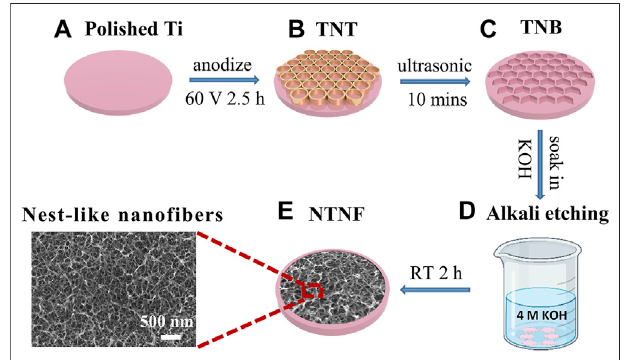
FIGURE 1 | Schematic diagram of preparing TNT and NTNF. (A) Polished Ti and (B) TiO 2 nanotubes (TNT) prepared on the surface of titanium by electrochemical anodization at 60 V voltage for 2.5 h; (C) titanium nanobowl (TNB) created by sonicating the TNT in deionized water for 10 min to remove the nanotubes (D) by soaking TNB in 4M KOH alkaline aqueoussolutionfor2 hatroomtemperature andnormalpressureforalkaline etching, and (E) nest-like nano fi ber structure